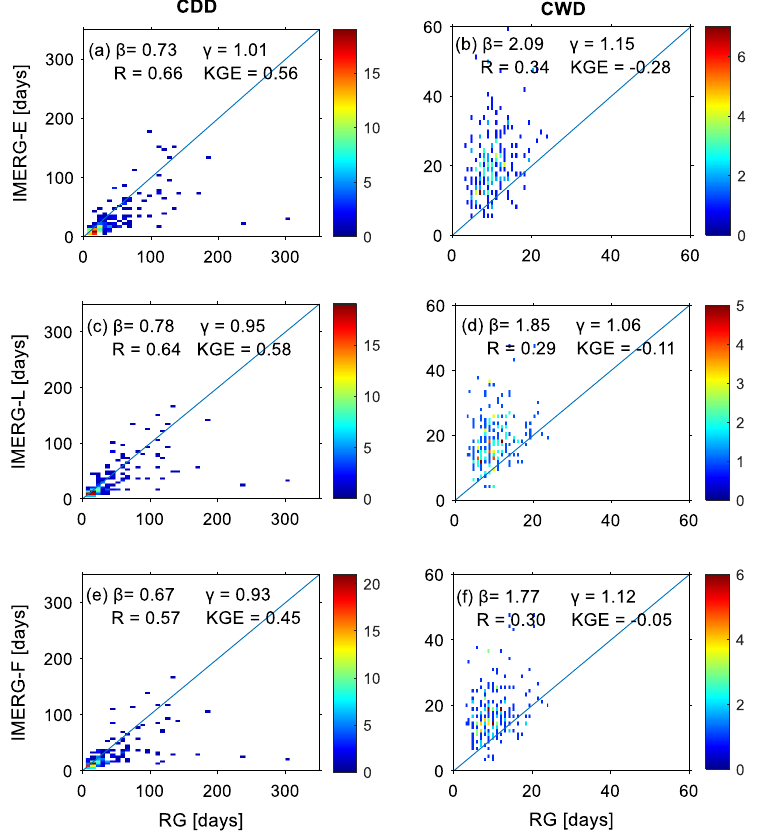
Figure 6. Scatter plot of precipitation-duration-based indices from IMERG and RG observation, namely CDD ( a , c , e ) and CWD ( b , d , f ), for IMERG-E (top), L (middle) and F (bottom). The color indicates the number of data counts.